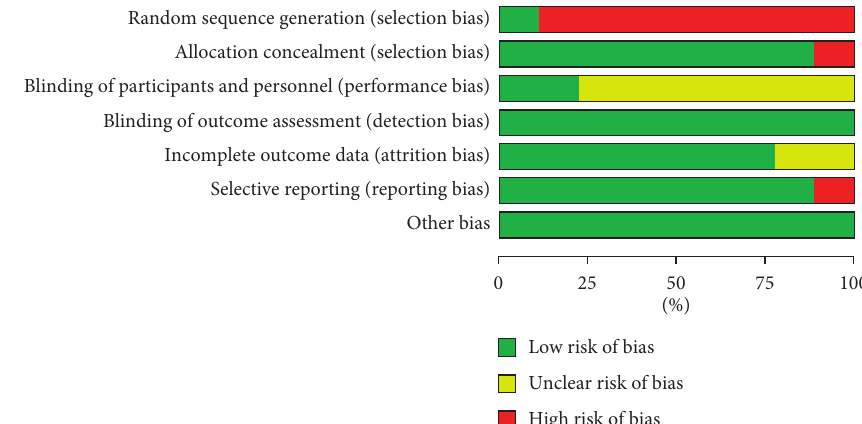
Figure 2: Quality assessment of the included studies: low (green hexagons), unclear (yellow hexagons), and high (red hexagons).